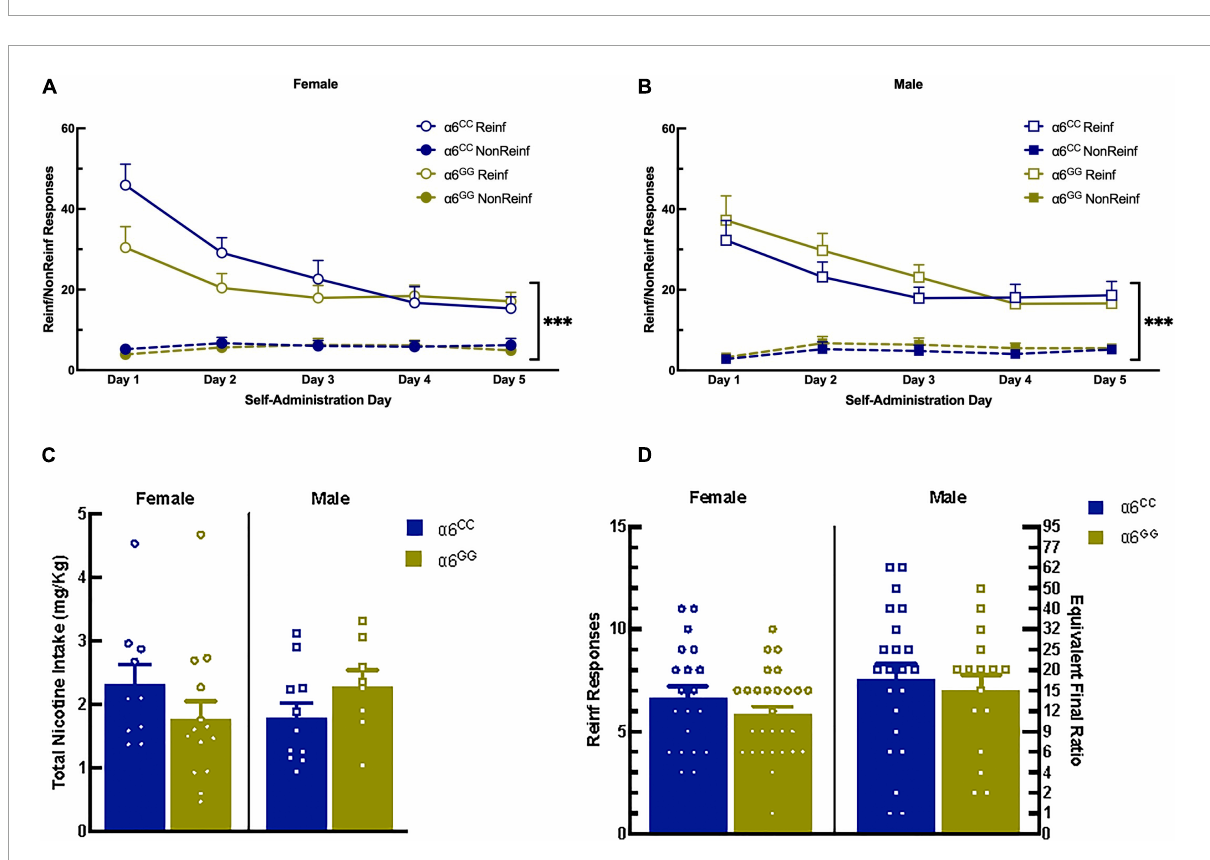
FIGURE3 The human CHRNA 6 3 (cid:48) -UTR SNP knock-in does not impact nicotine self-administration, progressive ratio, and nicotine intake. Female (A) and male (B) , α 6 CC and α 6 GG , mean daily 1-h responses ± SEM for nicotine self-administration at FR5TO20 schedule of reinforcement. No genotype or sex differences were observed for nicotine intake (C) or breakpoint values (D) . ∗∗∗ p < 0.001. N = 8–14/group. Circles represent females and squares represent